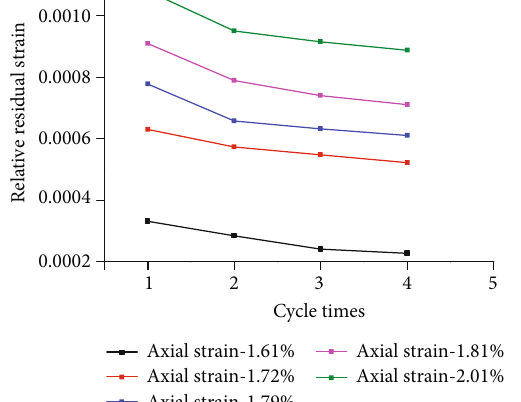
Figure 14: The relative residual strain of ε di ff erent axial